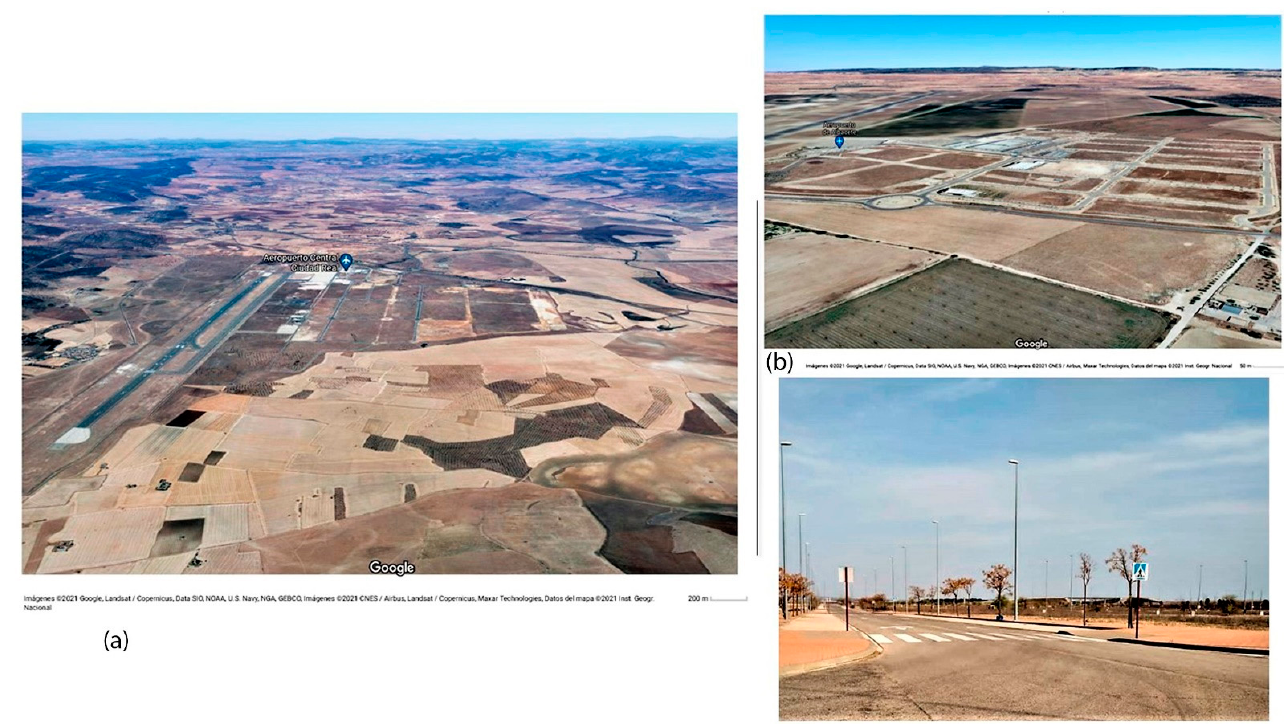
Figure 3. ( a ) Ciudad Real airport, left; ( b ) vacant lots at the aeronautics and logistics park in Albacete, right. Sources: Google Maps, use permitted for non-commercial purposes (https://about.google/brand-resource-center/products-and-services/geo-guidelines/#google-maps (accessed on 19